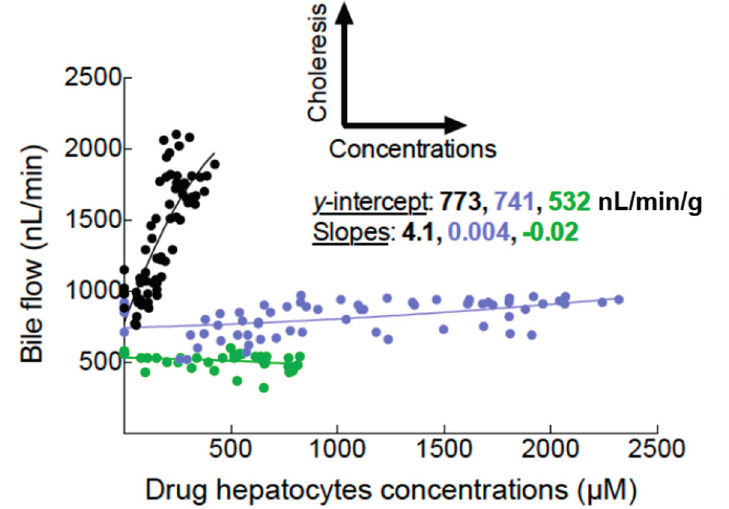
Figure 4. Plots between drug bile excretion rates ( x -axis) and bile flow rates ( y -axis). The three experimental groups are described in Figure 1. BOPTA (black circles, n = 5); BOPTA in Mrp2-deficient livers (green circles, n = 3); MEB (blue circles, n =